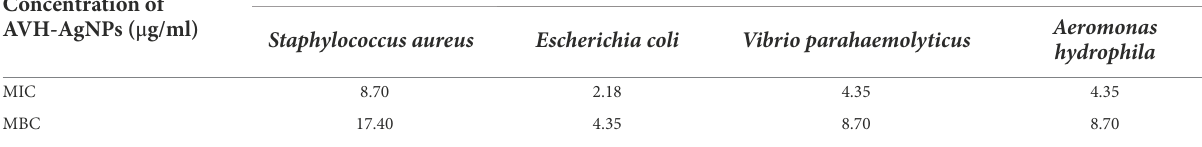
TABLE 1 In vitro antibacterial activity of